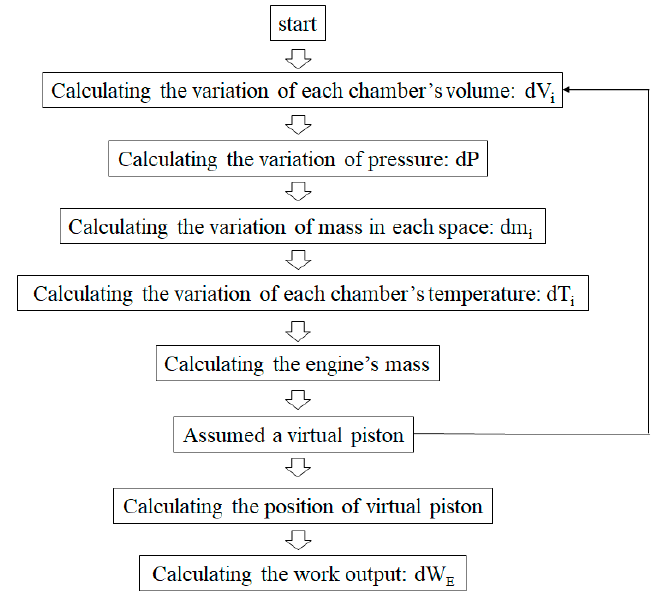
Figure 6. Flowchart of simulation process for virtual piston based Vuilleumier model.